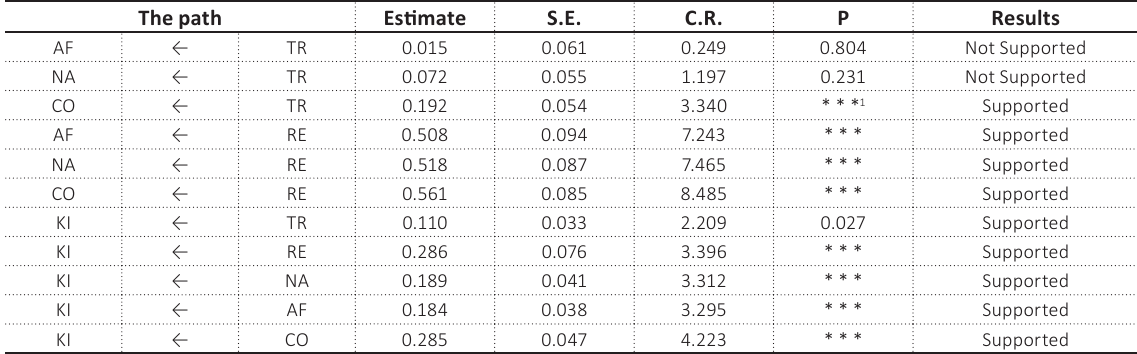
Table 8. Path coefficient analysis of the structural equation